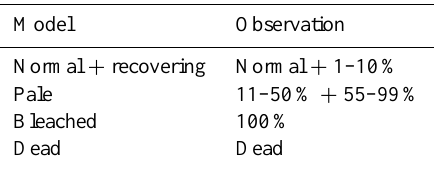
Table 3. Translation of the states used to classify the condition of the coral in the observations of Baird and Marshall (2002) to the five states used in the model.